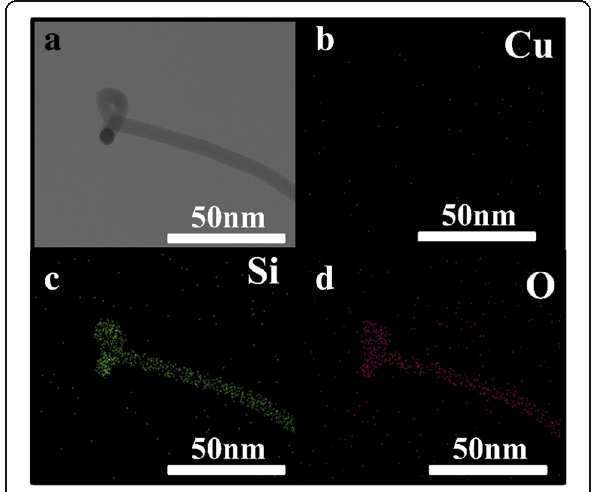
Fig. 7 TEM and EDS mapping images of the tip part of the nanowire. a shows the TEM image of the tip part of the wire